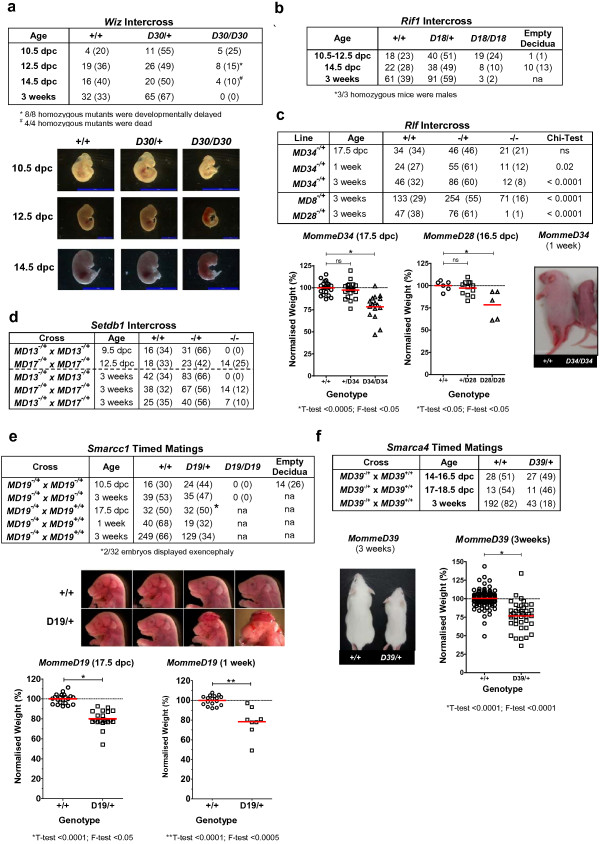
MommeD mutants show abnormal embryonic development. Timed matings and intercrosses of MommeD mutants. (a)WizMommeD30 mice; data show the number of mice observed (and in brackets the percentage) at 10.5 days post-coitum (dpc), 12.5 dpc, 14.5 dpc and at weaning. Representative embryos are shown. (b)Rif1MommeD18 mice; data show the number of mice observed (and in brackets the percentage) at 10.5 to 12.5 dpc, 14.5 dpc and at weaning. na, not applicable. (c)Rlf mutants; data show the number of mice observed (and in brackets the percentage). Embryonic weights were measured from intercrosses of RlfMommeD34 and RlfMommeD28 mice. Homozygous embryos from both had a significant increase in weight variation at 17.5 dpc or 16.5 dpc, respectively. Weights for each litter were normalized to the average weight of wild-type embryos in that litter. Each data point represents an individual. Homozygotes were smaller than wild-type littermates at one week after birth. ns, not significant. (d)Setdb1MommeD13 and Setdb1MommeD17 mice; data show the number of mice observed (and in brackets the percentage). (e)Smarcc1MommeD19 and Smarcc1MommeD19 mated to wild-type mice revealed incomplete penetrance of heterozygous lethality after birth. Data show the number of mice (and in brackets the percentage). Weights of 17.5 dpc Smarcc1MommeD19 embryos and pups were, on average, less than that of wild-type littermates (T-test, P < 0.0001) and showed greater variation (F-test, P < 0.05). Weights in each litter were normalized to the average weight of wild-type embryos in that litter. Each data point represents an individual. (f)Smarca4MommeD39 heterozygotes showed reduced viability. Data show the number of mice and in brackets the percentage. Heterozygotes were smaller than their wild-type littermates. Smarc4MommeD39/+ weighed less (T-test, P < 0.0001) and weights were more variable (F-test, P<0.0001) than wild types. Weights in each litter were normalized to the average weight of wild-type embryos in that litter. Each data point represents an individual.